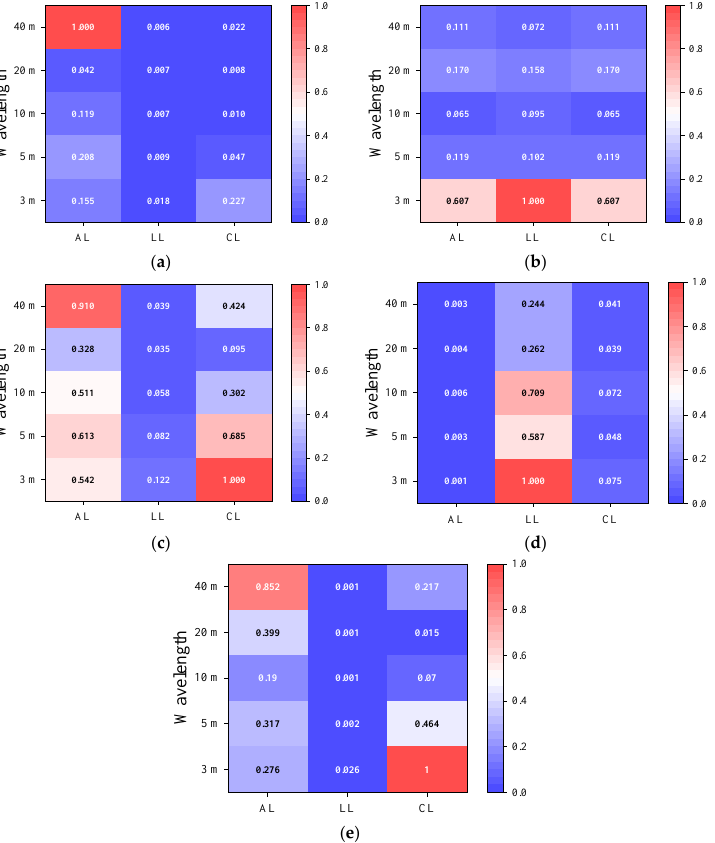
Figure 18. Comprehensive influence factors for the dynamic indicators of the irregularities in front of the turnout: ( a ) Derailment coefficient; ( b ) Wheel unloading rate; ( c ) The lateral acceleration of the vehicle body; ( d ) The vertical acceleration of the vehicle body; ( e ) Wheelset lateral force.